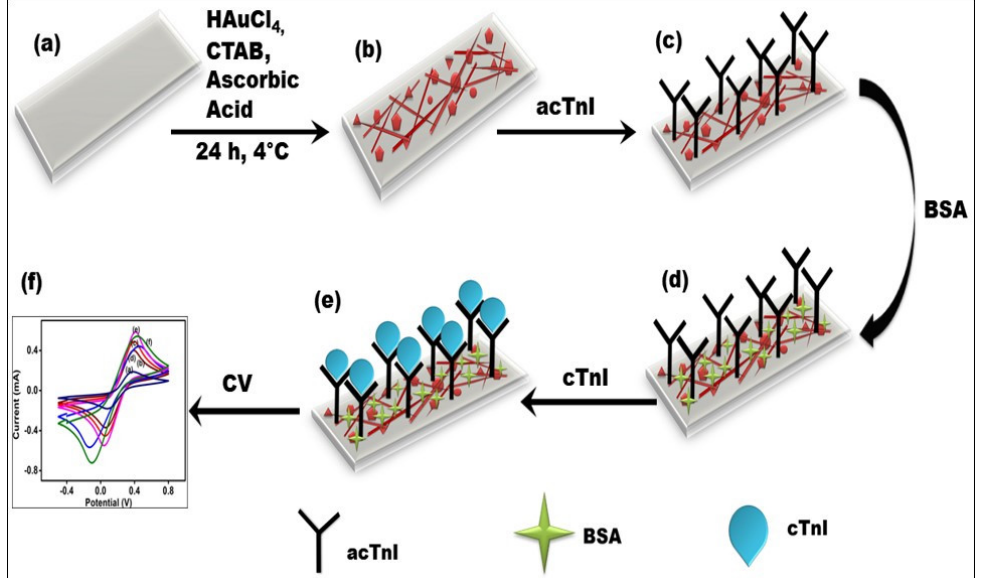
Figure 5. Schematic illustration of the fabrication steps of BSA/acTnI/Cys/AuNCs/APTMS/ITO immunoelectrodes ( a ) Bare ITO ( b ) AuNCs/APTMS/ITO ( c ) acTnI/Cys/AuNCs/APTMS/ITO ( d ) BSA/acTnI/Cys/AuNCs/APTMS/ITO ( e ) cTnI/BSA/acTnI/Cys/AuNCs/APTMS/ITO ( f ) cyclic voltammetry graph of surface modifications.